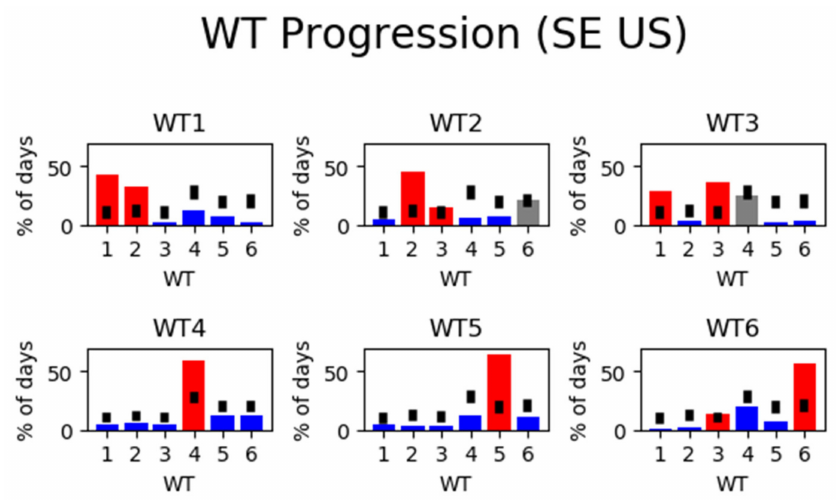
Figure 6. The progression of the WTs. The 95% confidence interval of the WT background frequency (the occurrence of WT transition due to chance) is shown with black shading. Frequencies significantly greater than the background frequency are shown with red bars; frequencies significantly less than the background bars are shown with blue